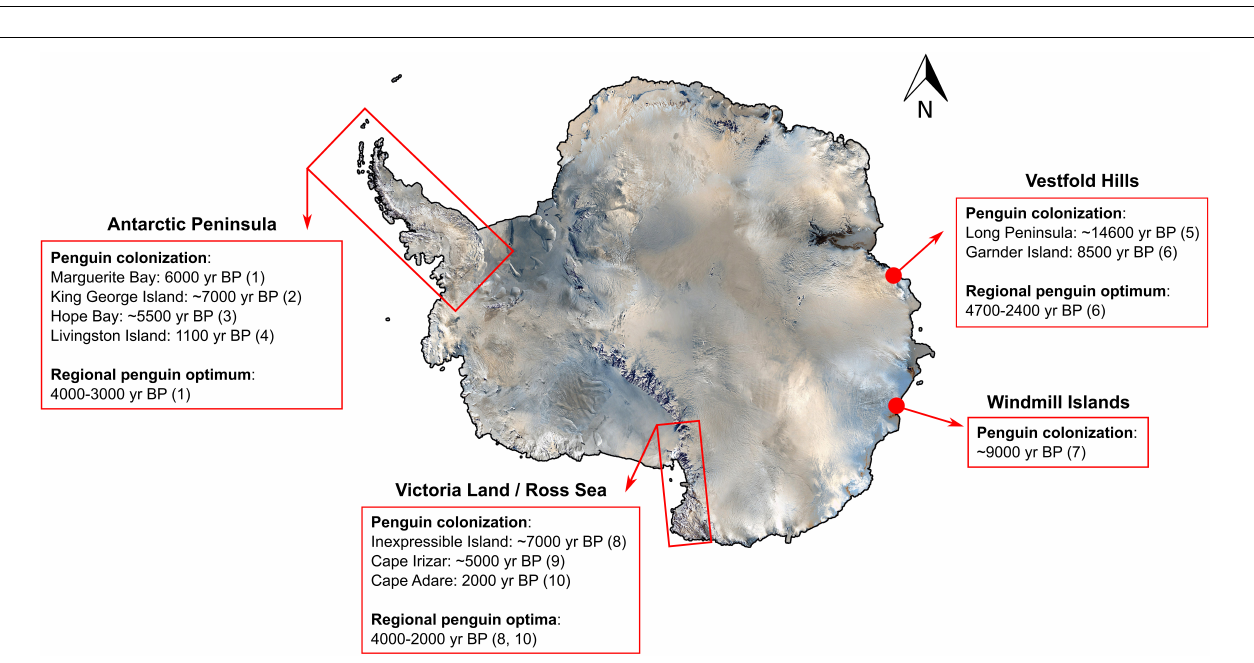
FIGURE 5 | Earliest penguin colonization and regional optima since the last Antarctic glaciation period. Modified and updated from Huang et al. (2009a) and Sun et al. (2013). References include (1) Emslie and McDaniel (2002); (2) Emslie et al., 2020; (3) Zale, 1994; (4) Emslie et al., 2011; (5) Gao et al., 2018a; (6) Huang et al., 2009b; (7) Emslie and Woehler, 2005; (8) Emslie et al., 2007; (9) Emslie, 2021; and (10) Emslie et al., 2018.